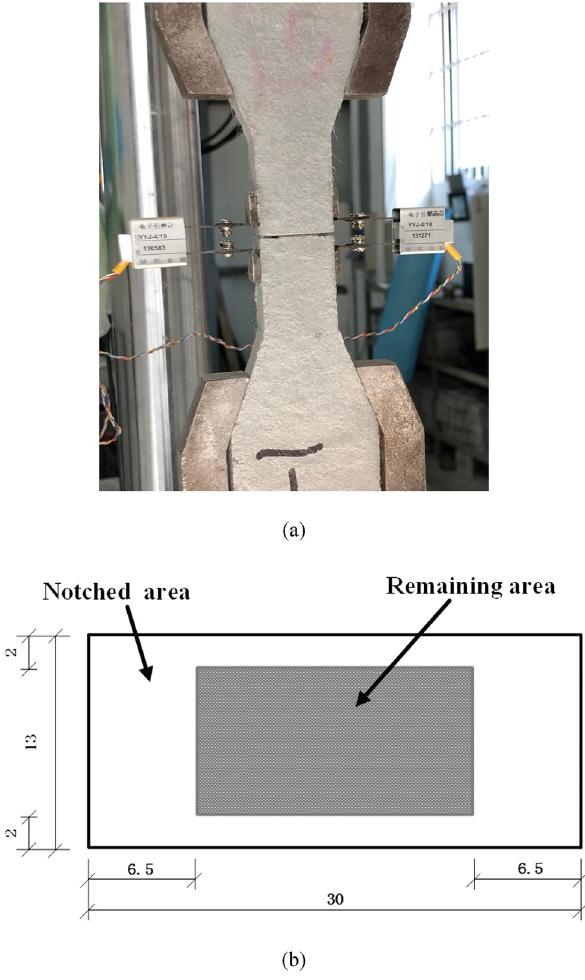
Figure 6: Single - crack tensile testing: ( a ) device of the test and ( b ) dimension diagram of the